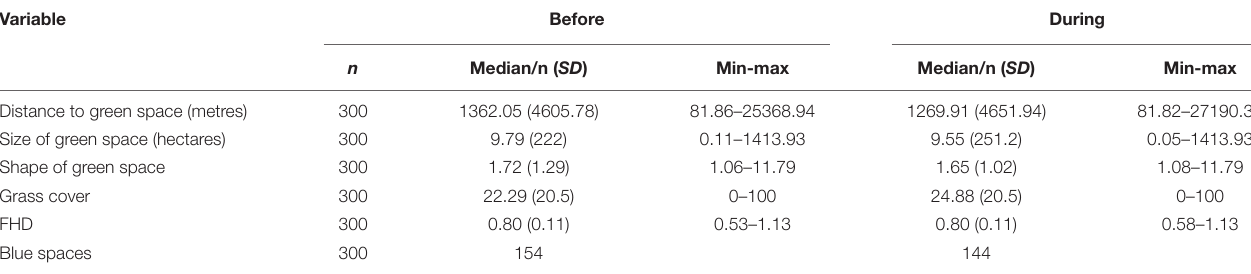
Variable Before During n Median/n ( SD ) Min-max Median/n ( SD ) Min-max Distance to green space